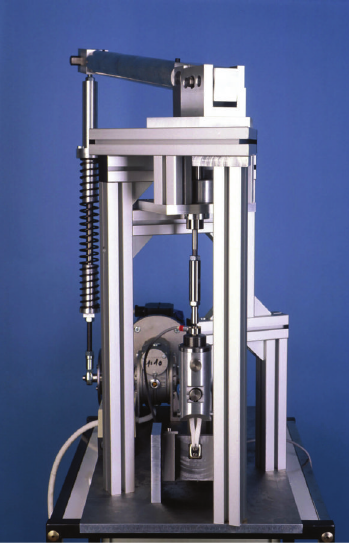
Figure 2: Test bench for cyclic load application on artificial ligament and fixation